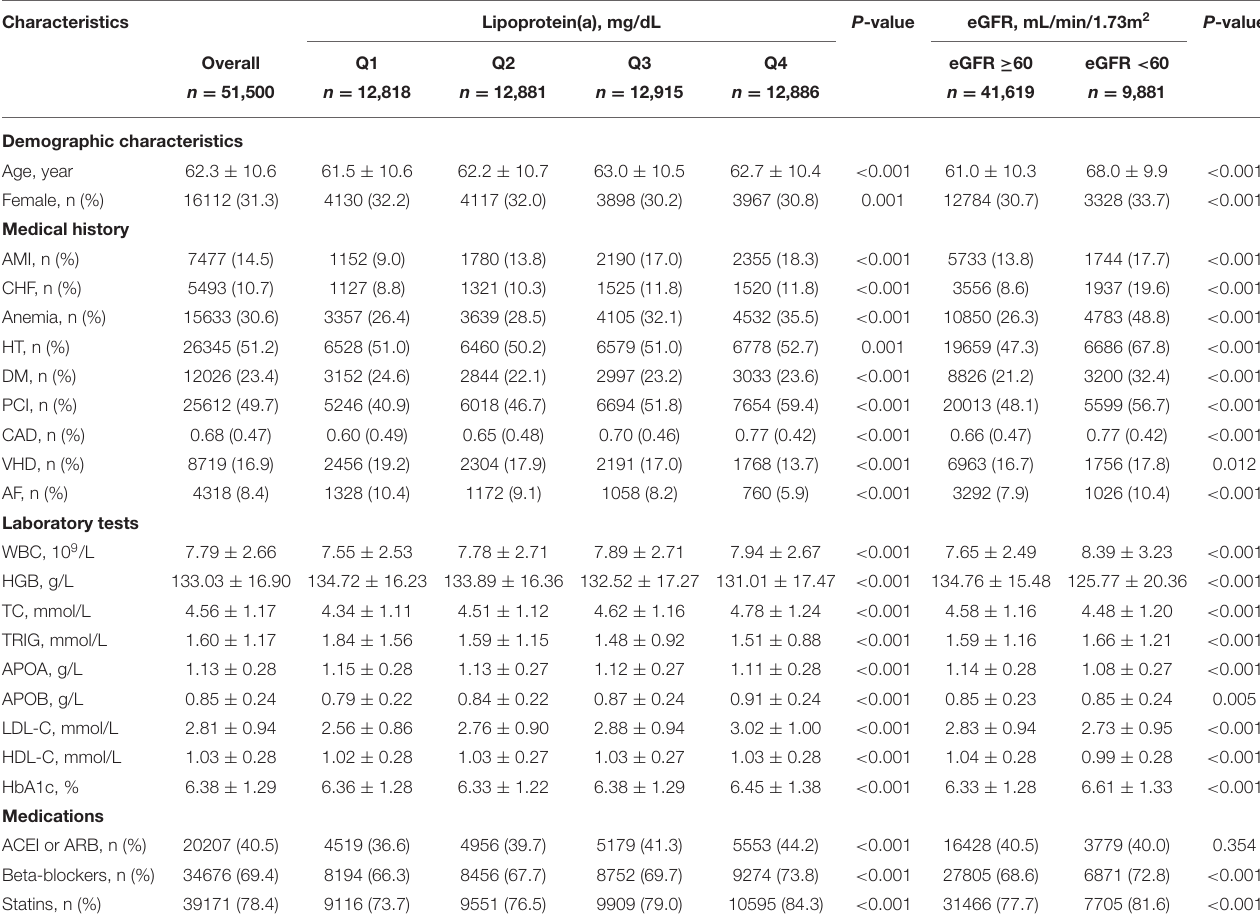
TABLE 1 | Baseline characteristics across eGFR and lipoprotein(a) categories.